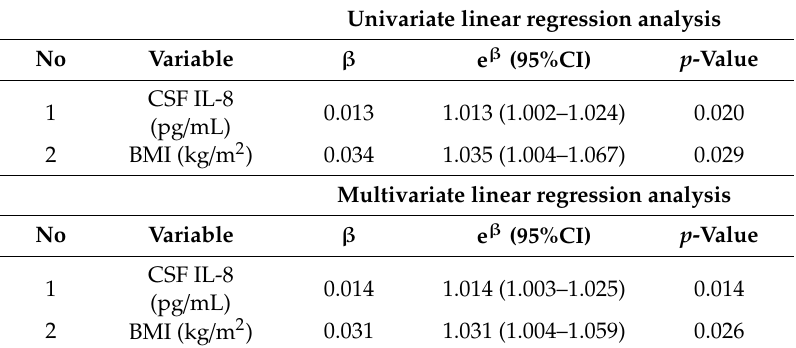
Table 5. Univariate and multivariate linear regression analysis results for logarithm of the brain aneurysm